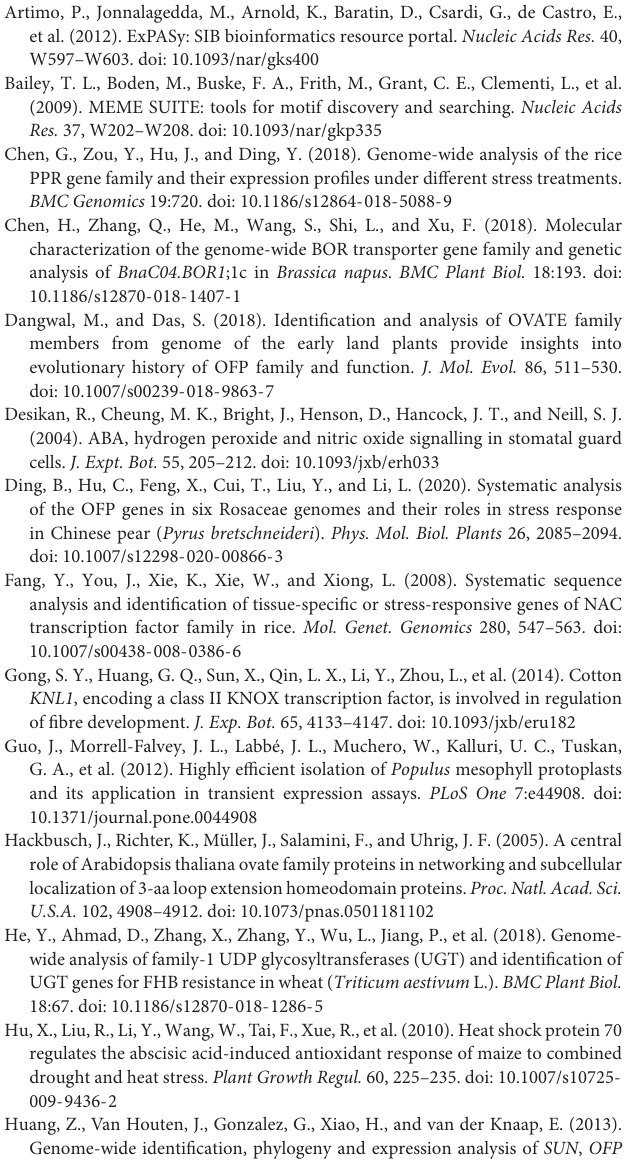
Supplementary Figure 6 | Distribution of hormone-responsive elements in the promoter region of PtOFP genes. Supplementary Table 1 | All primers used in this study. Supplementary Table 2 | The genomic sequences of PtOFP genes. Supplementary Table 3 | The CDS sequences of PtOFP genes. Supplementary Table 4 | The Protein sequences of PtOFPs. Supplementary Table 5 | The promoter sequences of PtOFP